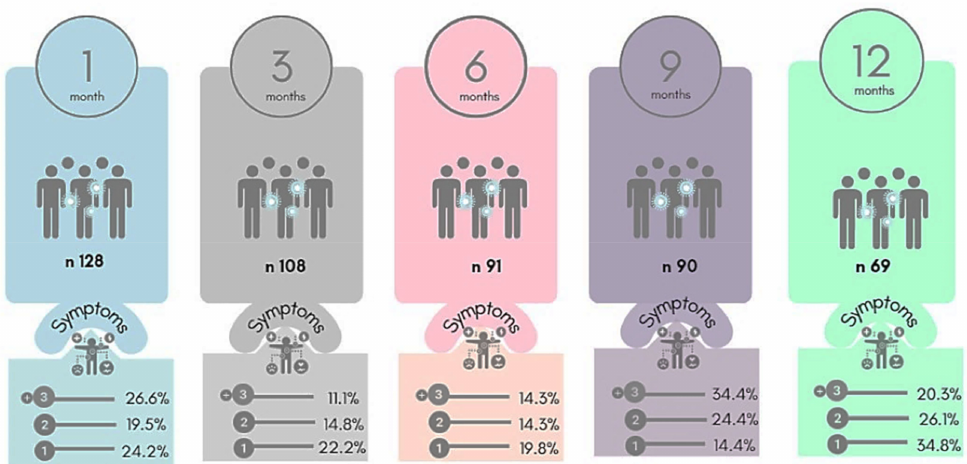
Figure 1. Number of symptoms during the follow-up. Licensed under CC BY 4.0. To view a copy of this license, visit http://creativecommons.org/licenses/by/4.0/ (accessed on 7 November